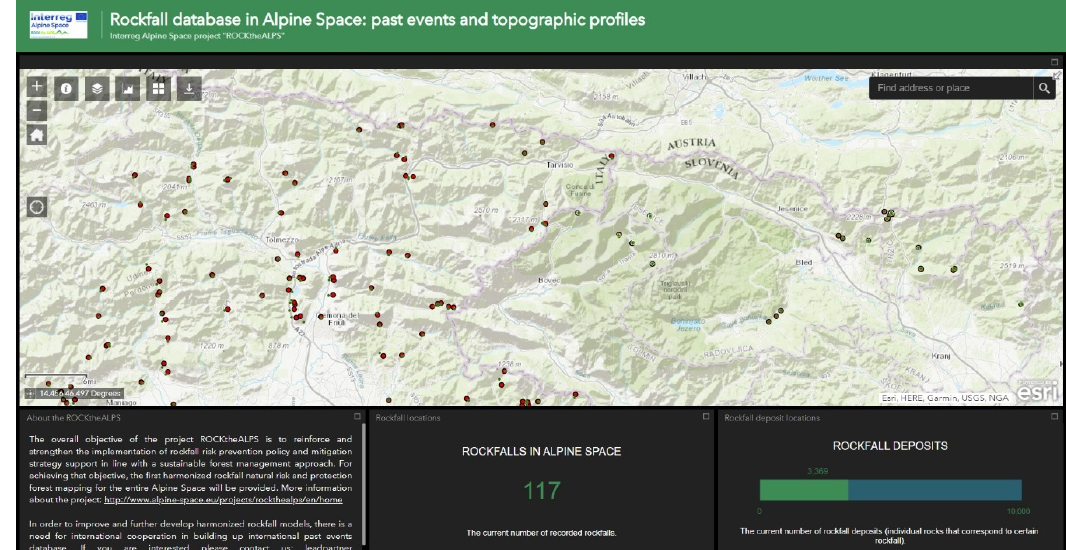
Figure 5. The main feature of the WebGIS is a Web Map showing past rockfall events (red dot — rockfall source area, green dot — rockfall deposit). The lower part of the Web Map is built from three elements: a short description of the purpose of the database (left), the number of recorded rockfalls sites (middle) and rockfall deposits (right). The number of recorded rockfall sites and deposits changes with the changed scale of the Web Map and the number is adjusted to the number of records that can be observed on the changed Web Map extent. A navigation pane is located in the upper left corner and it includes the following elements: the information of the Web Map, a layer list, statistics about the data, basemap options, and download